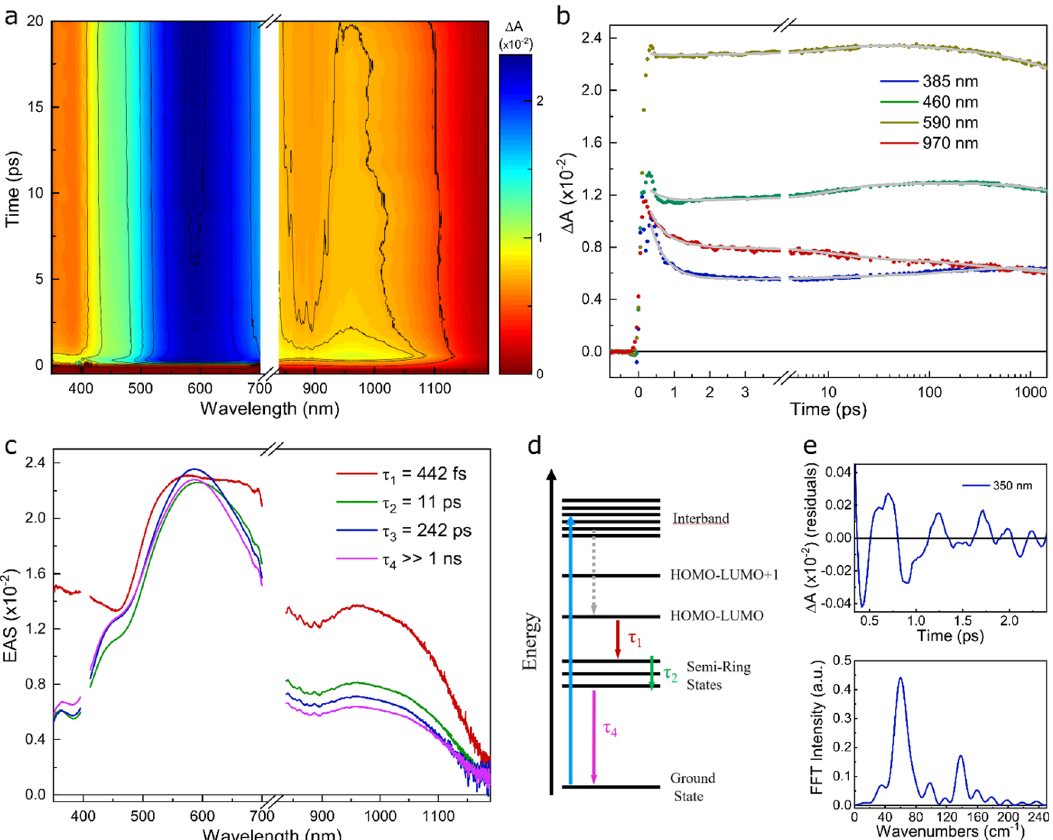
Fig. 3 Ultrafast spectroscopy of [Au 25 (SF 27 ) 18 ] 0 . a Δ A map of the crystal solution in PFO as a function of probe delay and probe wavelength. b Δ A time traces selected at speci fi c probe wavelengths. c EAS spectra obtained from global analysis fi t. d Model of electronic energy relaxation following 400 nm pump excitation. e Extracted coherent oscillations from Δ A time trace measured at 350 nm probe wavelength, after subtraction of a bi-exponential decay and its corresponding Fourier transform spectrum.